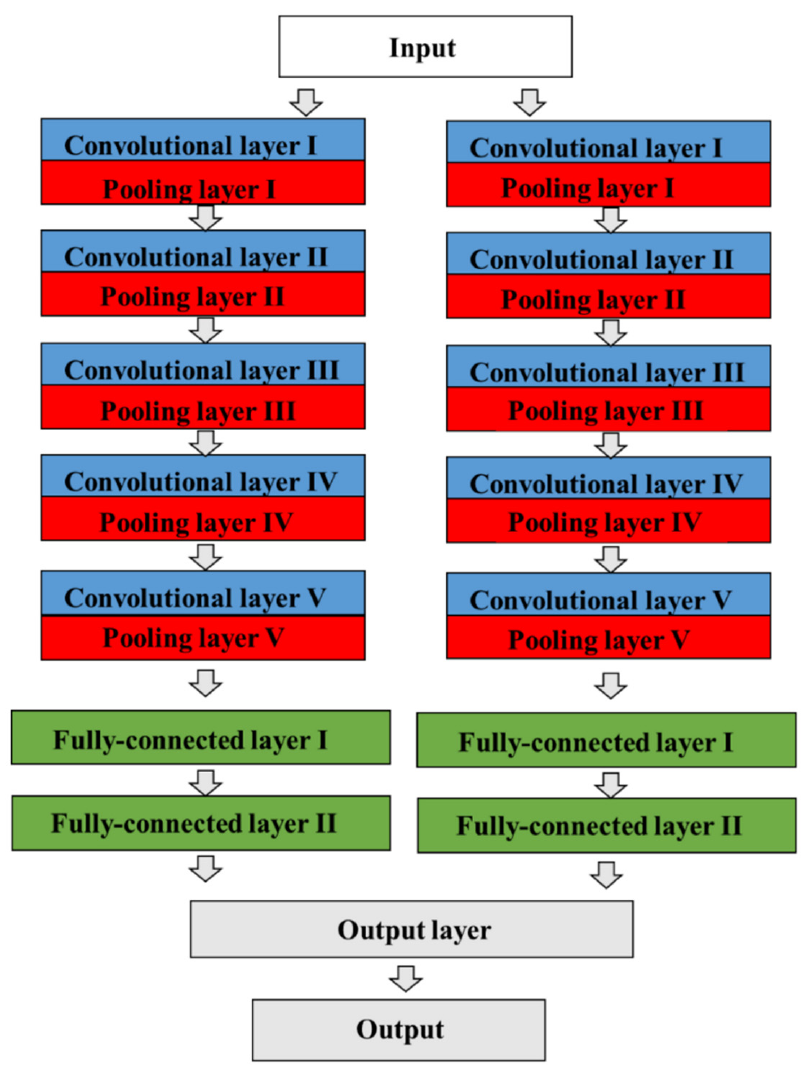
Figure 2. The architecture of a CNN model in AlexNet. The CNN contains a total of eight prelearned layers, which consist of five convolutional and max-pooling layers, three fully connected layers, dropout, data augmentation, rectified linear unit activations, and a stochastic gradient descent with momentum, including a total of 60 million parameters. The two adjacent convolutional and pooling layers are finally combined into a third fully connected